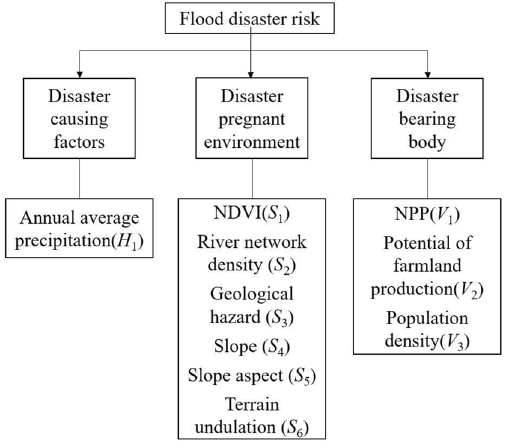
Figure 2. Flood Risk Assessment Indicator